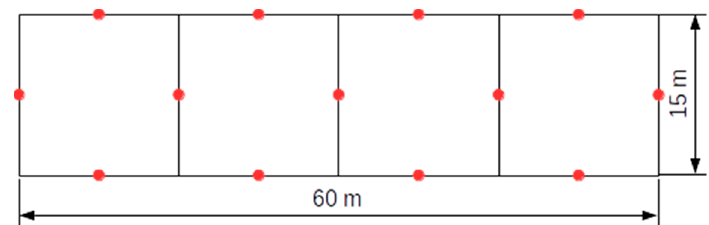
Figure 4. Scanning set-up adopted for the terrestrial LiDAR acquisition at the Bas Saint-Laurent test site. Each of the four sub-plots (black) were scanned from four different positions (red). Manual measurements were not included in the measurement protocol. The reference